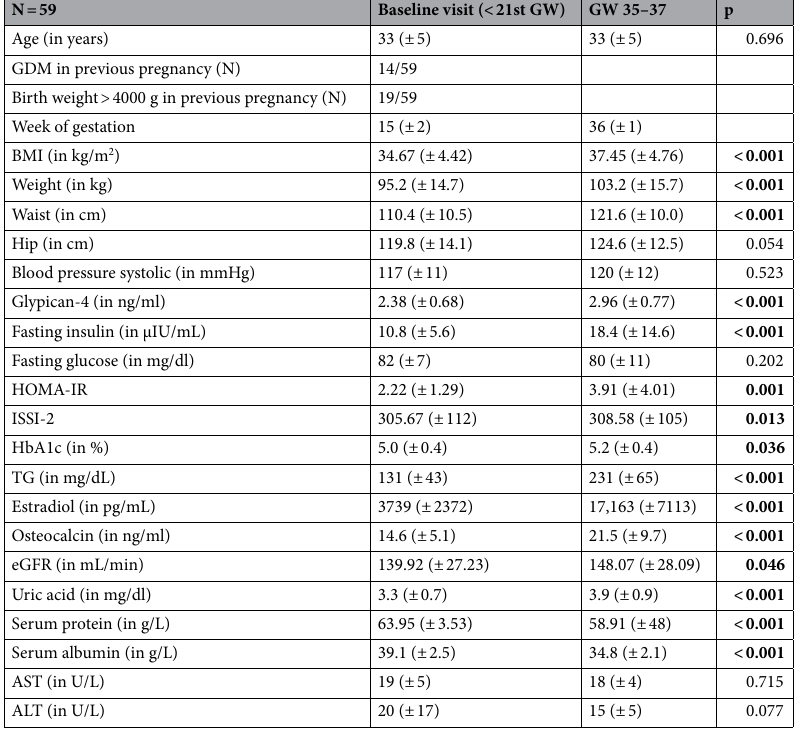
Table 1. Baseline characteristics and metabolic parameters of visit at < 21st GW and GW 35–37. Significant values are in bold. Continuous variables were summarized by mean ± standard deviation (SD) and categorical